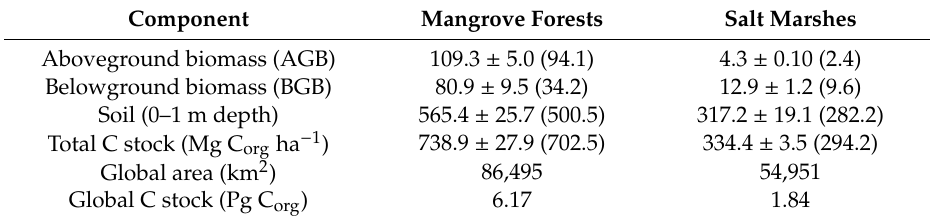
Table 1. Comparison of mean (±1 standard error, SE) carbon stocks between salt marsh and mangrove ecosystems. Units = Mg C ORG ha − 1 . Median values are in parentheses and in Figure 1. Mangrove data from [6]. Salt marsh g dry weight (DW) biomass was converted to g C ORG using percent C ORG content in roots + rhizomes (41.5 ± 1.2%) and shoots (38.5 ± 0.7%) of various species [7–15]. Salt marsh above- and below ground biomass data (from [16–47] and earlier references within). Global mangrove area